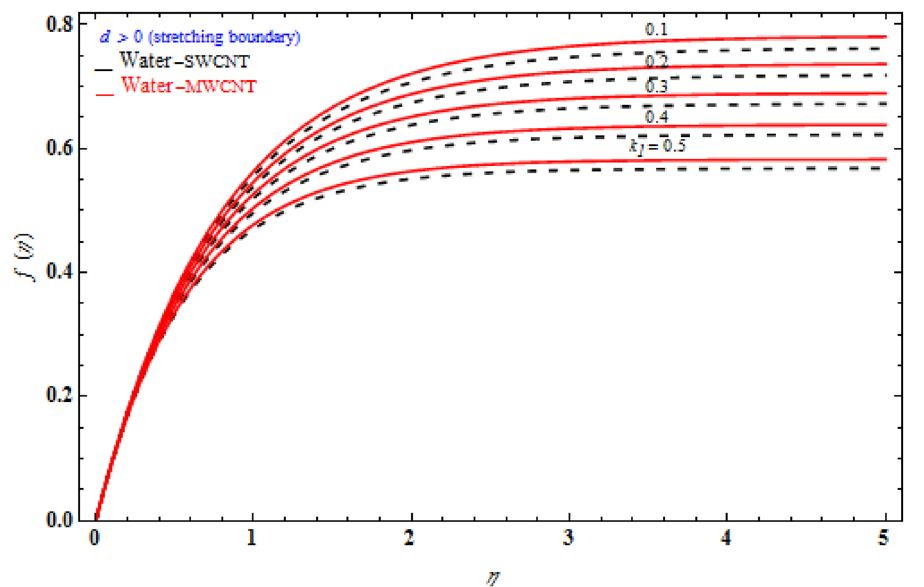
Figure 5. Impact of k 1 on transverse velocity with M = 1, Da -1 = 1, τ = 90° for stretching